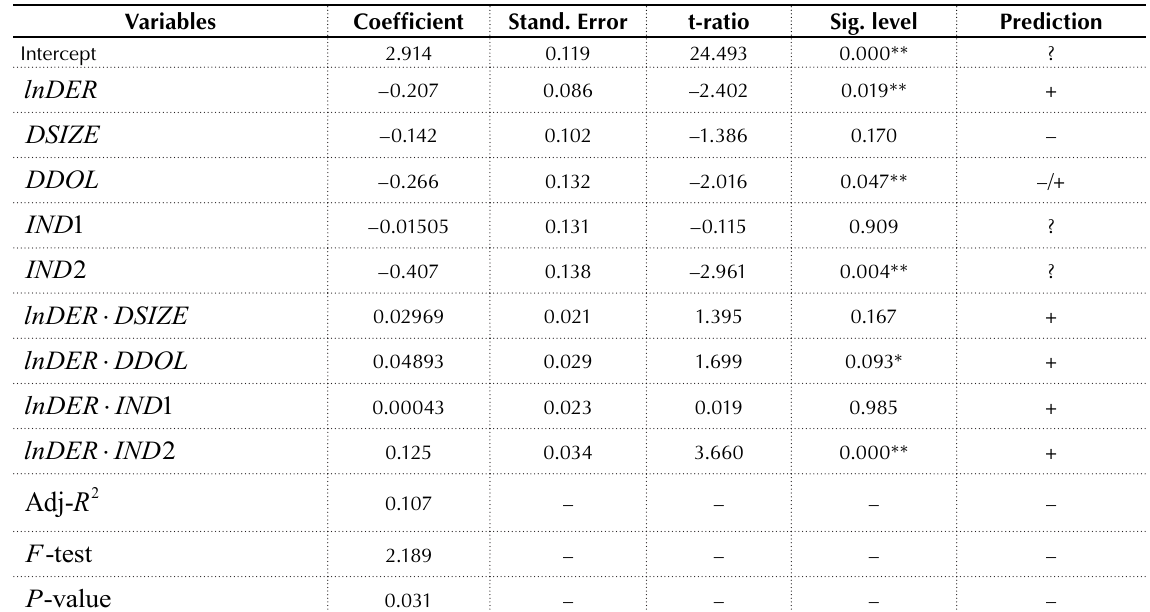
Table 3. The regression results of the relation between financial leverage and beta (moderated by size, operating leverage, and